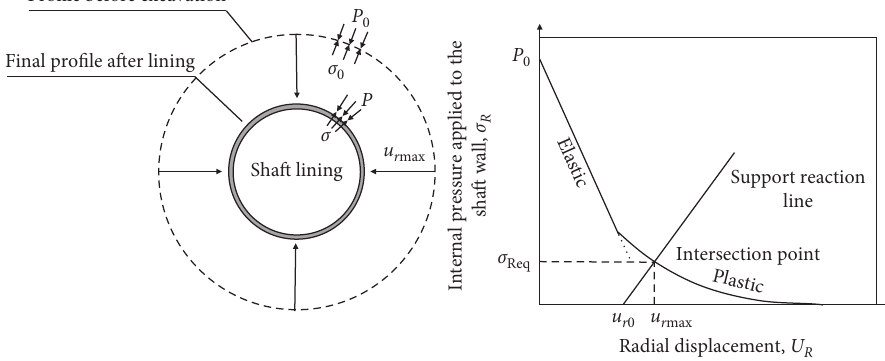
Figure 1: Schematic illustration of the convergence confinement method.